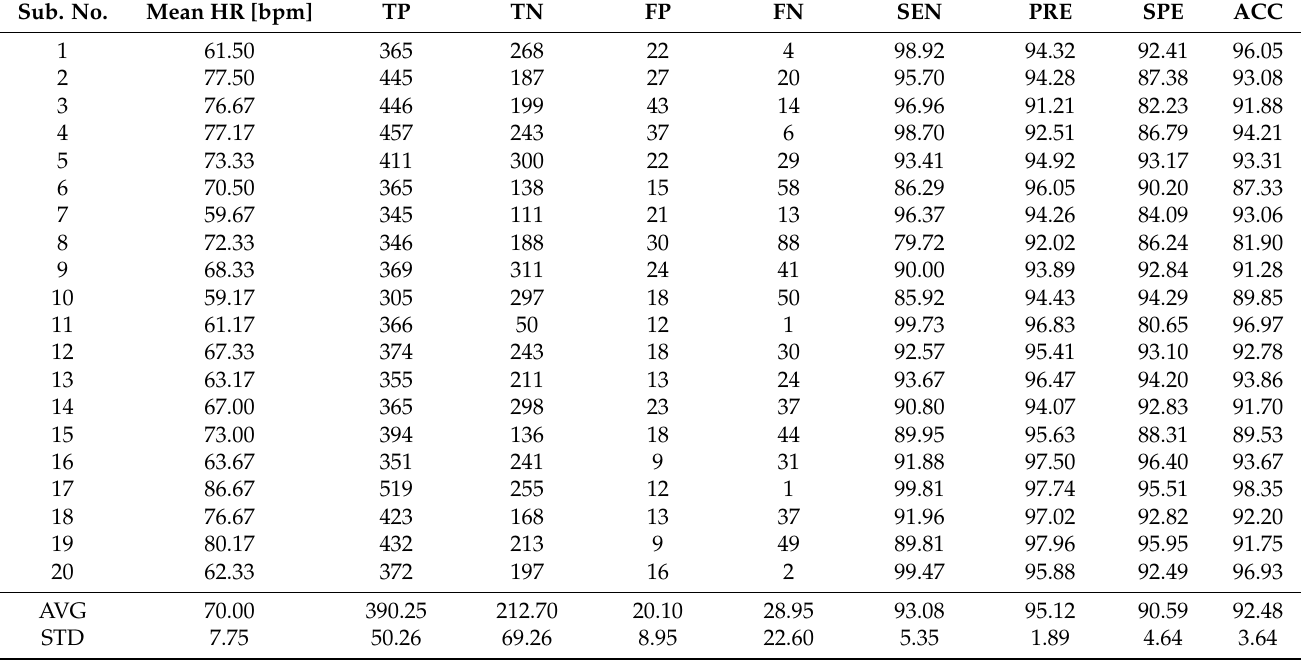
Table 8. Performance of the S2 peak detection in Model